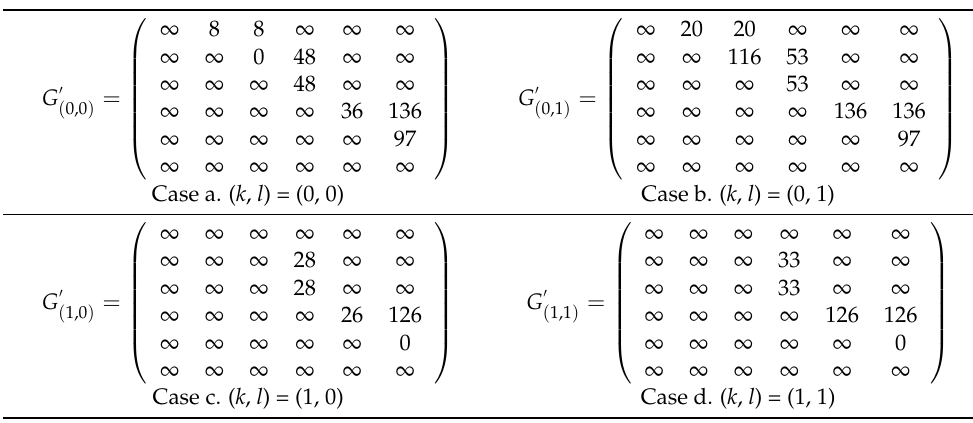
Table 2. Values for g ( i , j , k , l ), i , j ∈ H ∪ ( T + 1) and k , l ∈